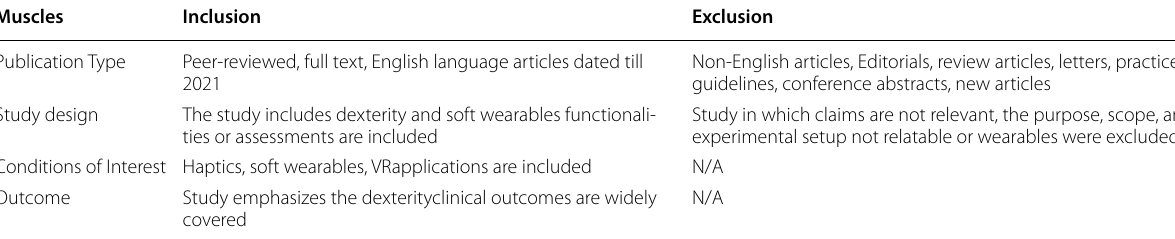
Table 1 An outline of the classification criteria considered in the methodology